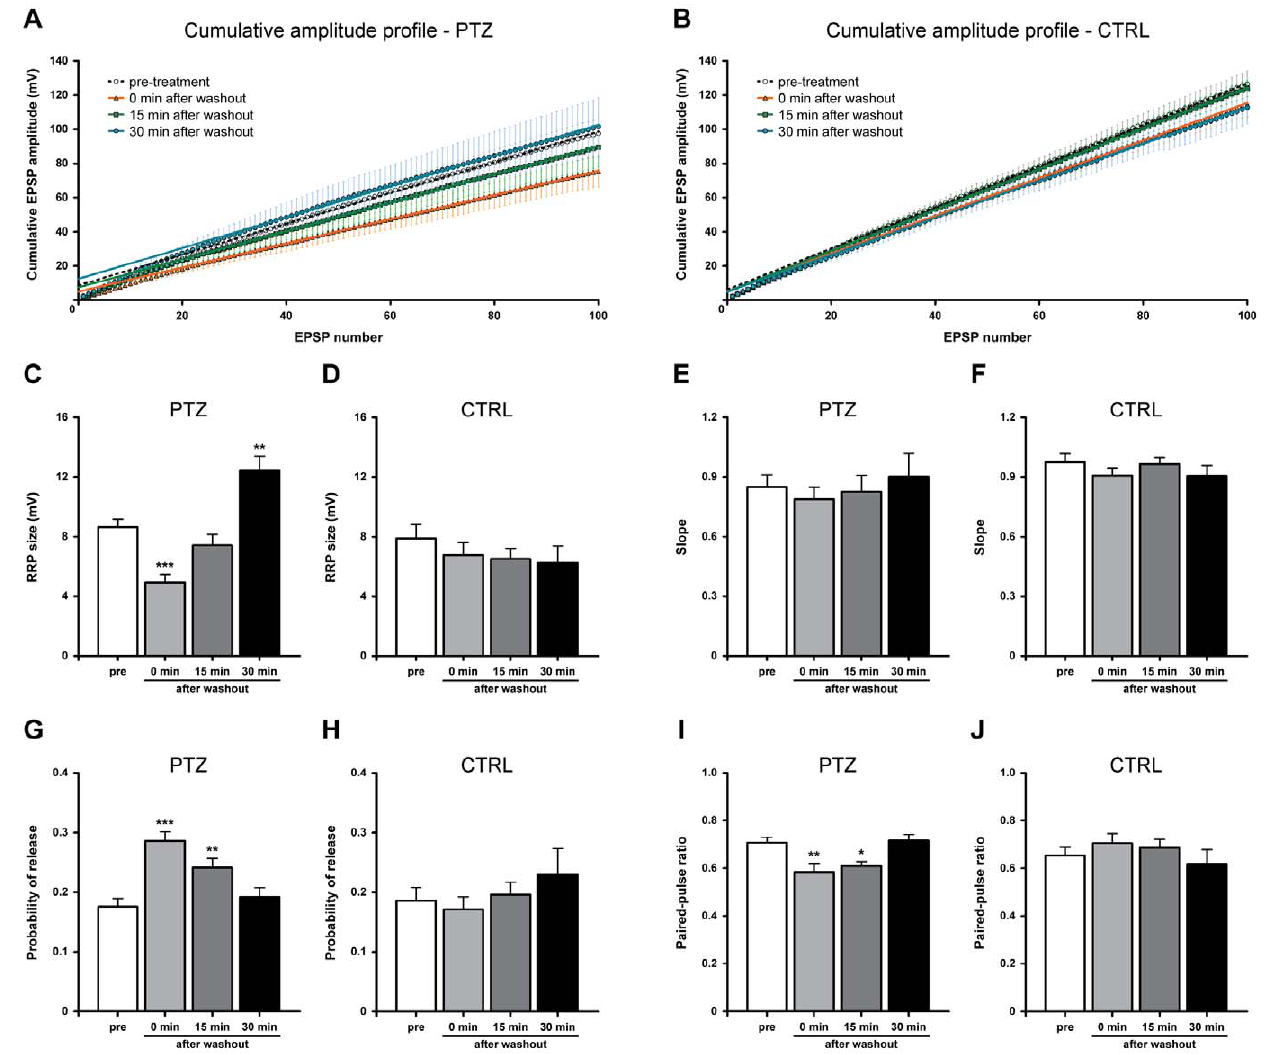
Figure 4. Epileptiform activity induces opposite changes in the RRP and P rel. (A,B) Cumulative curves of EPSP amplitudes evoked at 10 Hz at different time-points. The linear part was fitted as described in Methods. (C) Following PTZ exposure, the estimated RRP size, expressed in mV, significantly decreased soon after washout, recovered at 15 minutes and then increased 30 minutes post-treatment. (D) On the contrary, the RRP remained unchanged in control group. (E,F) Bar graph of mean values of slopes measured from the linear regression lines, indicating similar vesicle replenishment rates in both treated and untreated synapses. (G) Bar graph of P rel showing an increase in this parameter following epileptiform activity which returns to pre-treatment values at 30 minutes after drug washout. (H) No alteration was measured in untreated synapses. (I) Histogram of mean PPR values obtained from treated B2–B2 synapses. PTZ exposure transiently reduced PPR with a complete recovery at 30 minutes after washout. (J) No detectable changes in PPR were observed in control